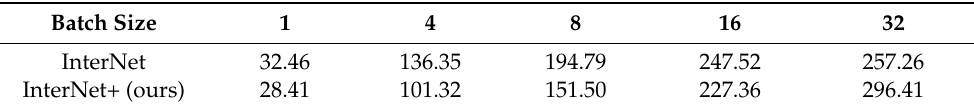
Table 4. The inference performance (frames processed per second) comparison of original model and ours in RHD dataset.